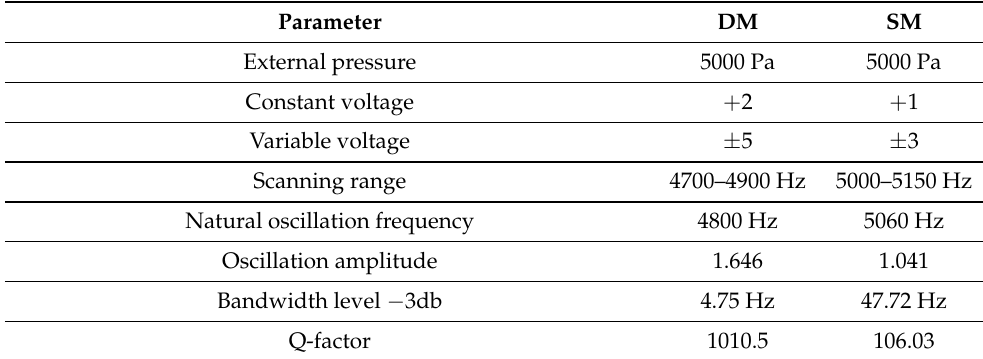
Figure 34. The measured amplitude–frequency response of the MEMS gyroscope in the SM. Table 10. Results of the experiment to determine the amplitude–frequency